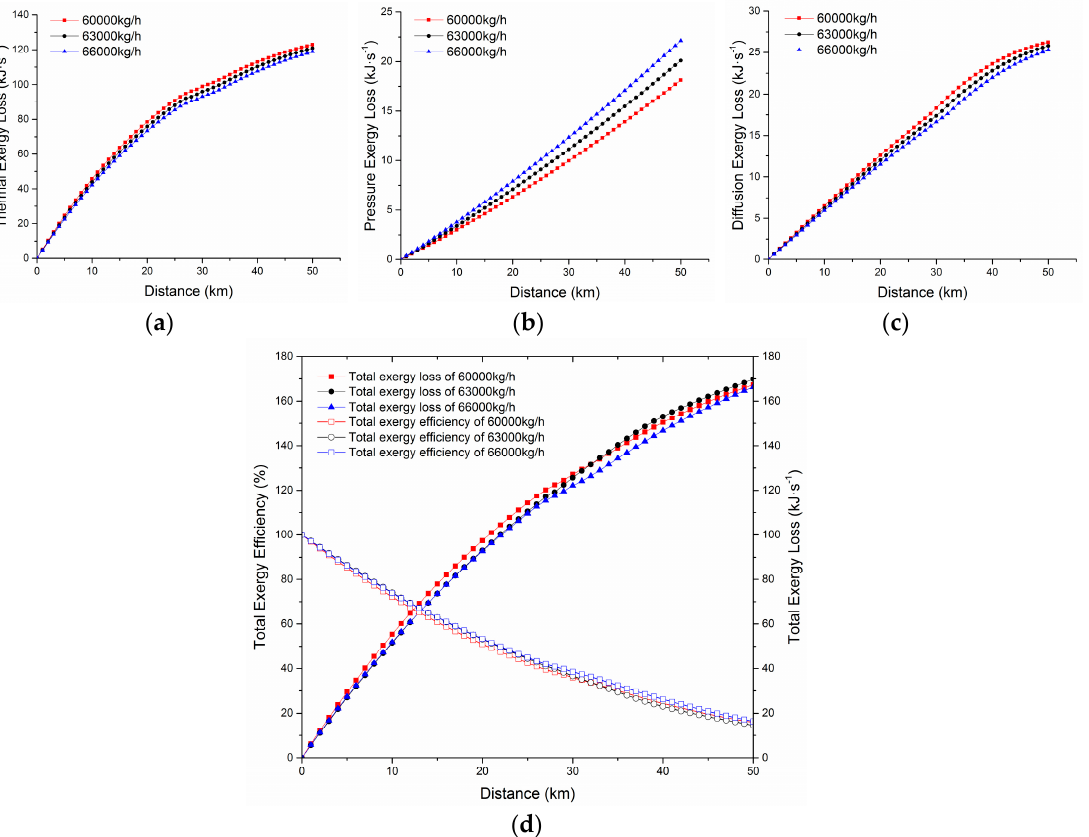
Figure 6. ( a ) The axial distribution of thermal exergy loss under different flow rates; ( b ) The axial distribution of pressure exergy loss under different flow rates; ( c ) The axial distribution of diffusion exergy loss under different flow rates; ( d ) The axial distribution of total exergy loss/efficiency under different flow rates.